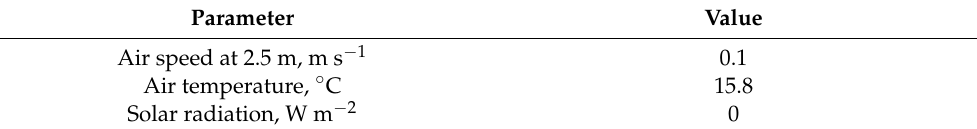
Table 2. Input values used as initial conditions at 12:00 am (at midnight), measured on 13 July 2019.